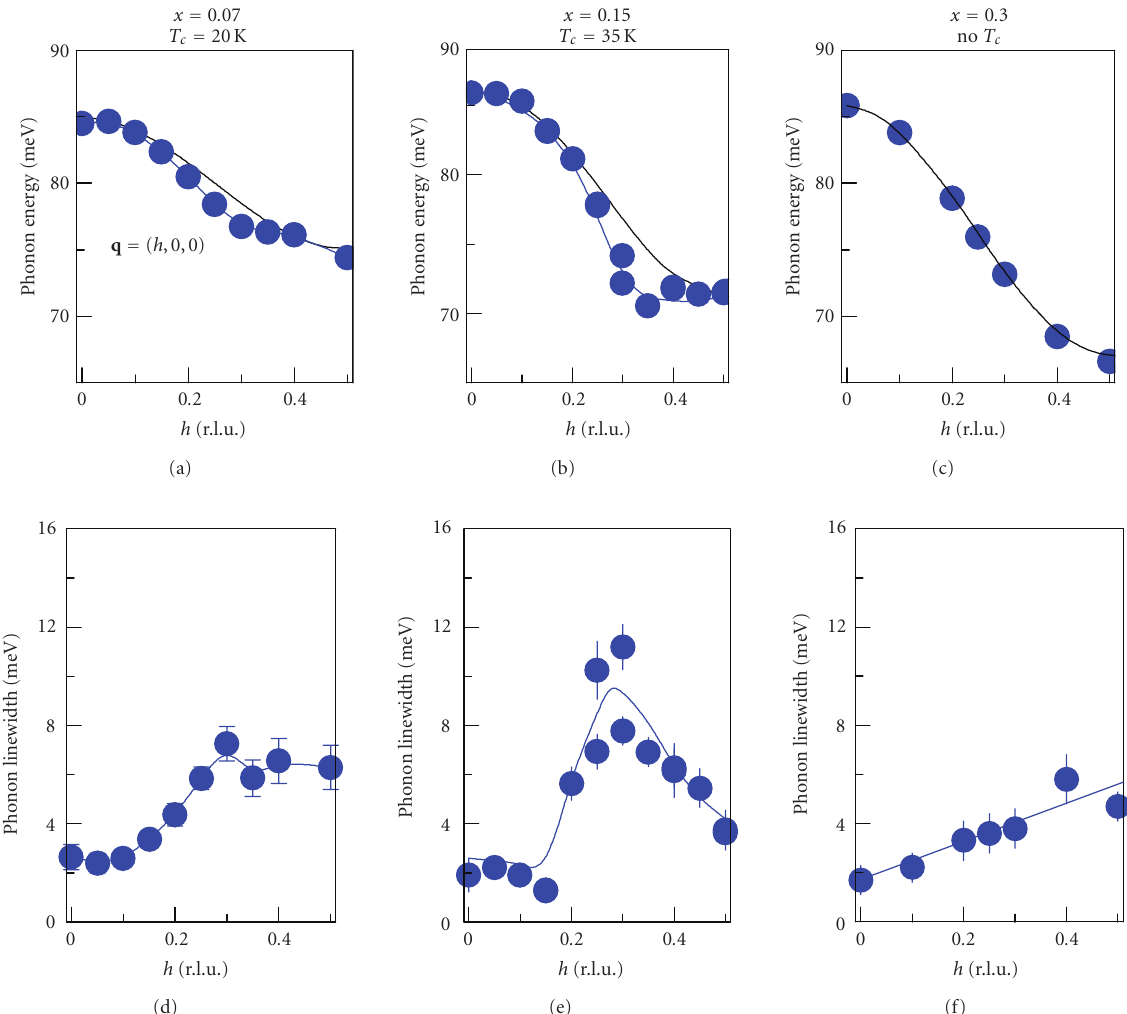
Figure 14: Bond-stretching phonon dispersion (top row) and linewidth (bottom row) at three doping levels. Black lines represent downward cosine dispersion. The overall increase in the linewidth of the bond-stretching mode towards the zone boundary appears to be doping- independent. Softening compared with the cosine dispersion as well as the linewidth enhancement half-way to the zone boundary do not shift with h between x = 0.07 and 0.15